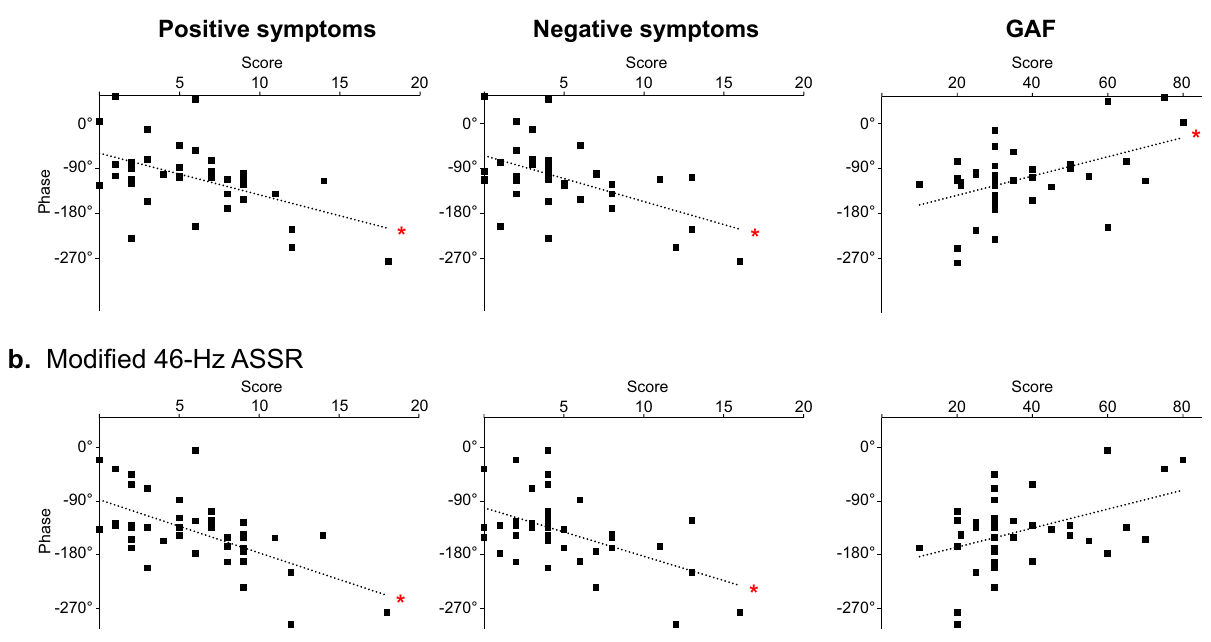
Figure 2. Phase delay with severity of the disease in patients with schizophrenia. The delayed phase was significantly correlated with positive and negative symptoms in patients with schizophrenia both in the basic 40-Hz ASSR (left and middle panels of a ) and in the modified 46-Hz ASSR (left and middle panels of b ). The delayed phase was also significantly correlated with lower GAF scores of patients in the basic 40-Hz ASSR (right panel of a ). * p <